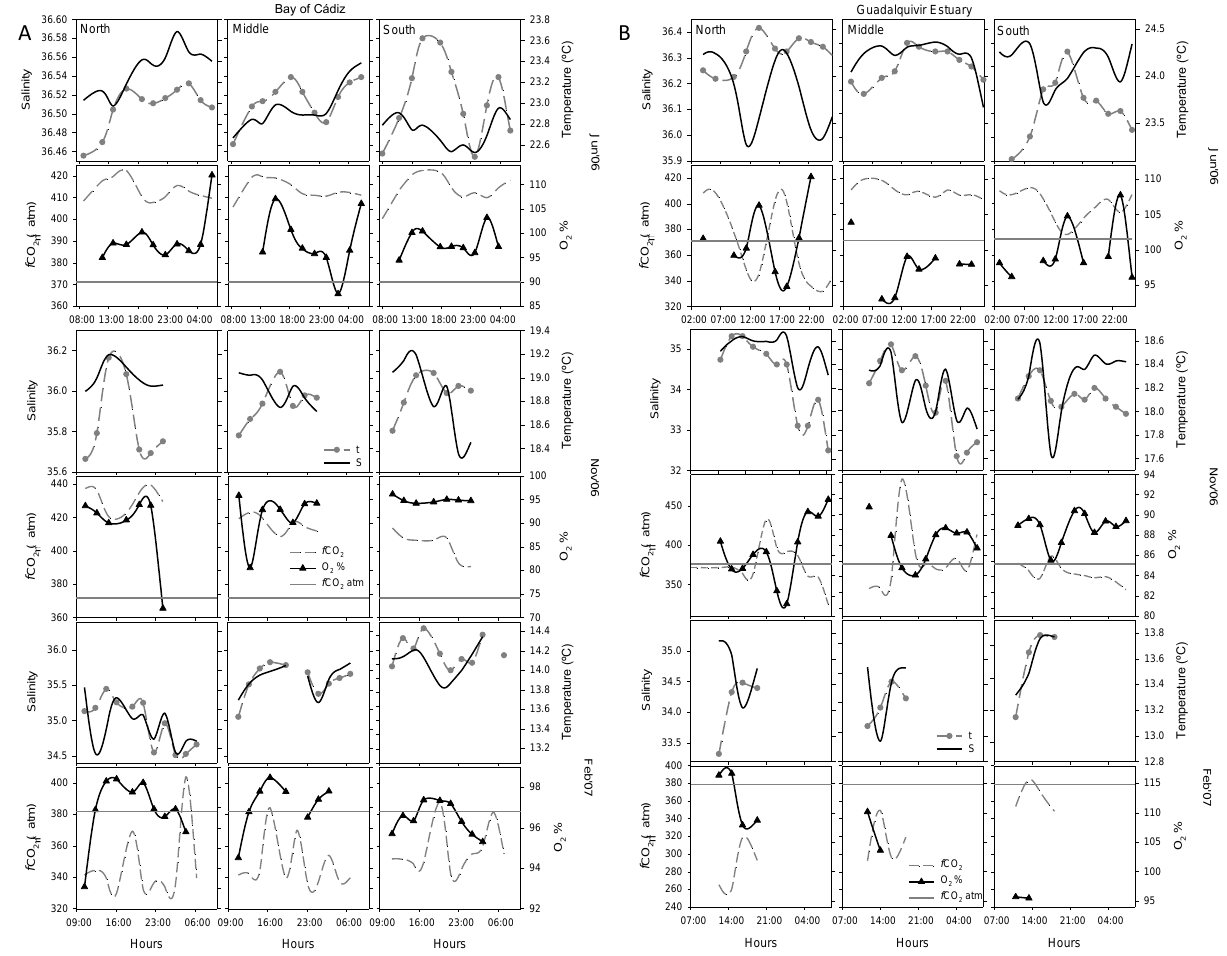
Fig. 3. Daily variations in surface seawater salinity (black solid line), temperature (grey dashed line with circle), f CO 2 (grey dashed line) and percentage of oxygen saturation (% O 2 ) (black solid line with triangles) from the transect off the Bay of C´adiz (A) and Guadalquivir estuary (B) at the three different stations (Fig. 1). Straight dark grey line is atmospheric f CO 2